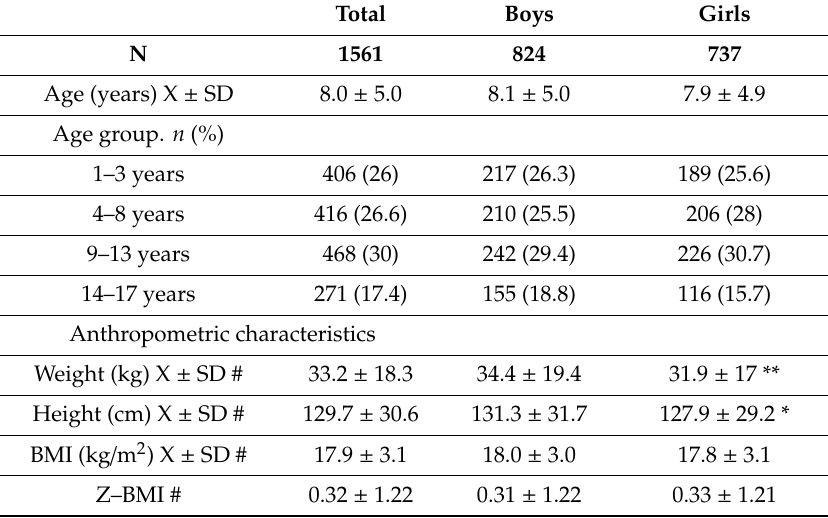
Table 1. Personal and anthropometric characteristics of children aged 1 to 17.9 years studied in the ENALIA Study, 2013–2014 (National Dietary Survey on the child and Adolescent Population). Details of children who take